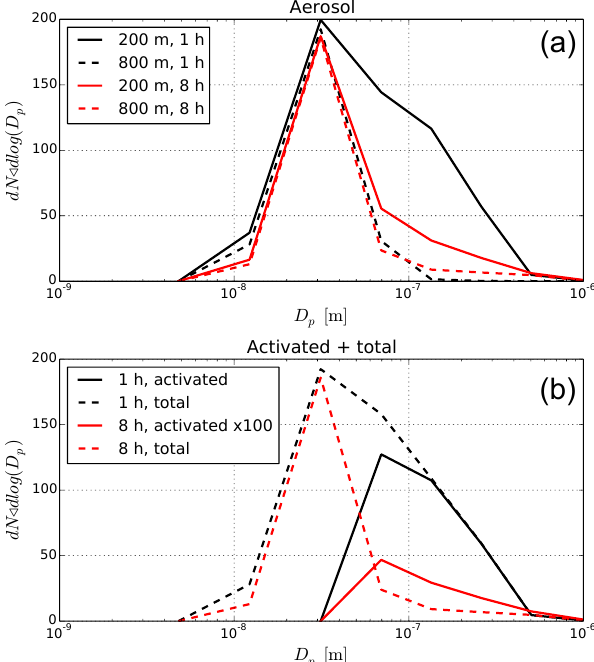
Figure 7. Size distributions of (a) dry/interstitial aerosol after spin- up (1h, black) and after 8h (red) averaged over the domain at 200m (solid) and 800m (dashed) heights, and (b) activated (solid) and to- tal (activated + interstitial) aerosol size distributions after the spin- up (black) and after 8h (red) sampled at 800 height. Please note that the concentration of activated particles at 8h is multiplied by 100 to be visible in the figure. D p is the particle